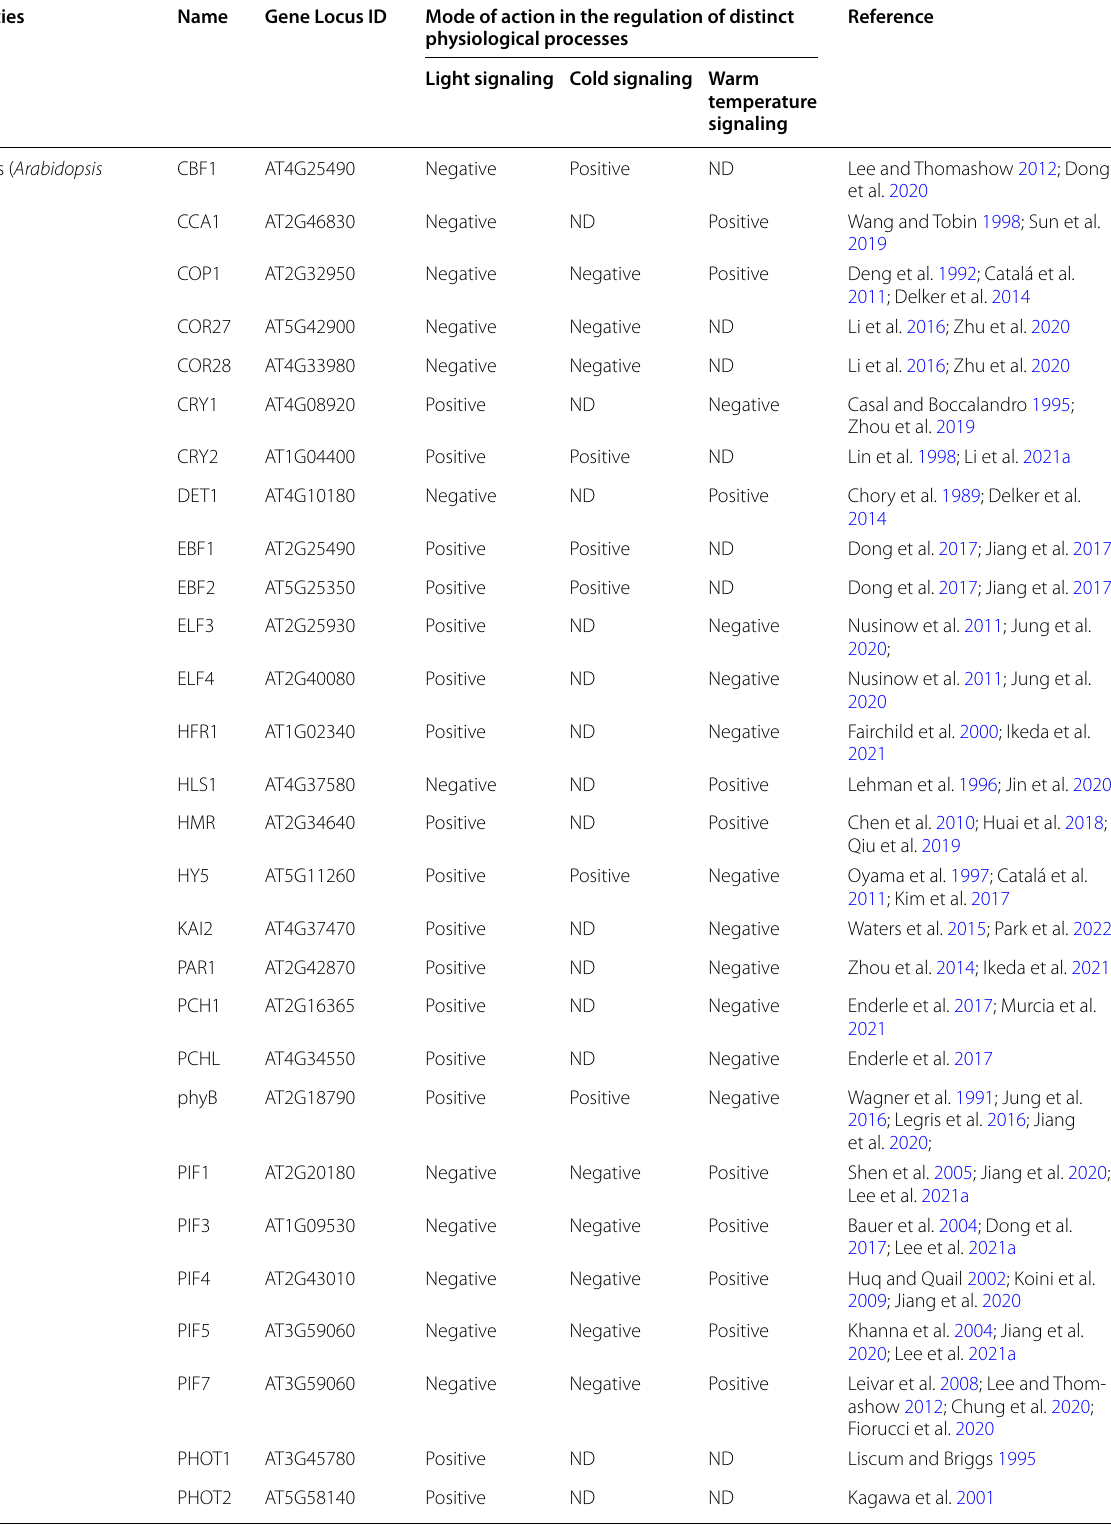
Table 1 Summary of key components involved in the regulation of light and temperature signaling Plant Species Name Gene Locus ID Mode of action in the regulation of distinct physiological processes